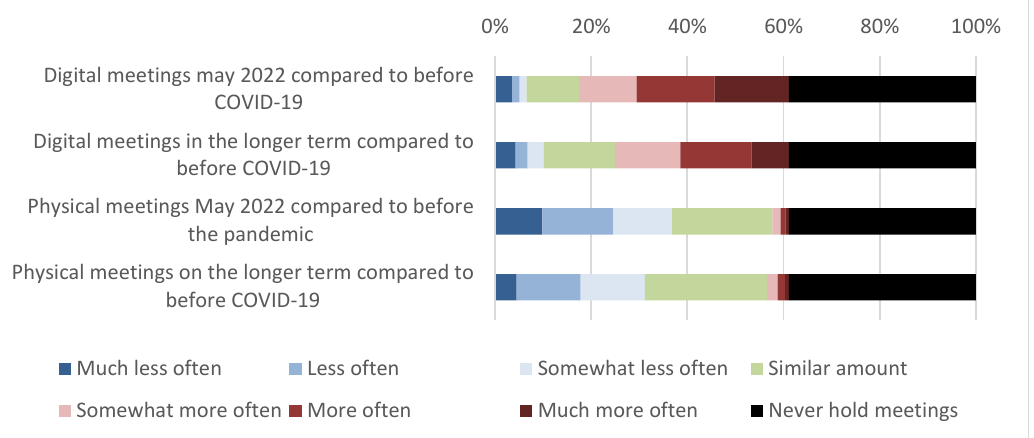
Figure 6. Current and intended amount of physical and digital meetings compared to pre- COVID (Data: MPN COVID-measurement of May 2022, N =